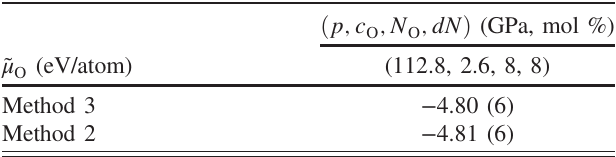
II. Excess chemical potential of oxygen in liquid iron at T ¼ 4300 K calculated using method 2 and compared to the data obtained with method 3. The system contains 149 Fe atoms and eight O atoms, and we use dN ¼ 8 (see